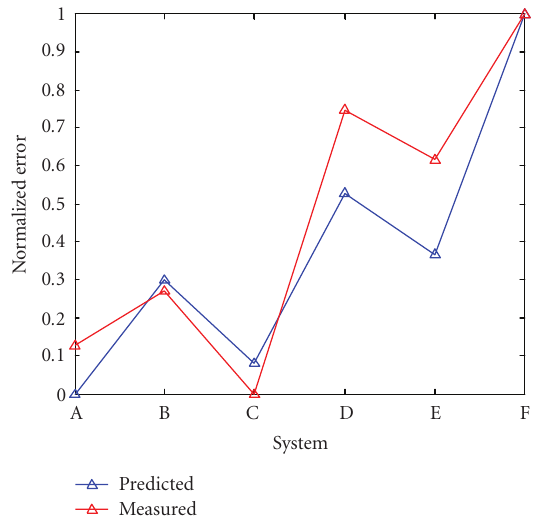
Figure 8: Predicted and measured errors for three-dimensional simulations.